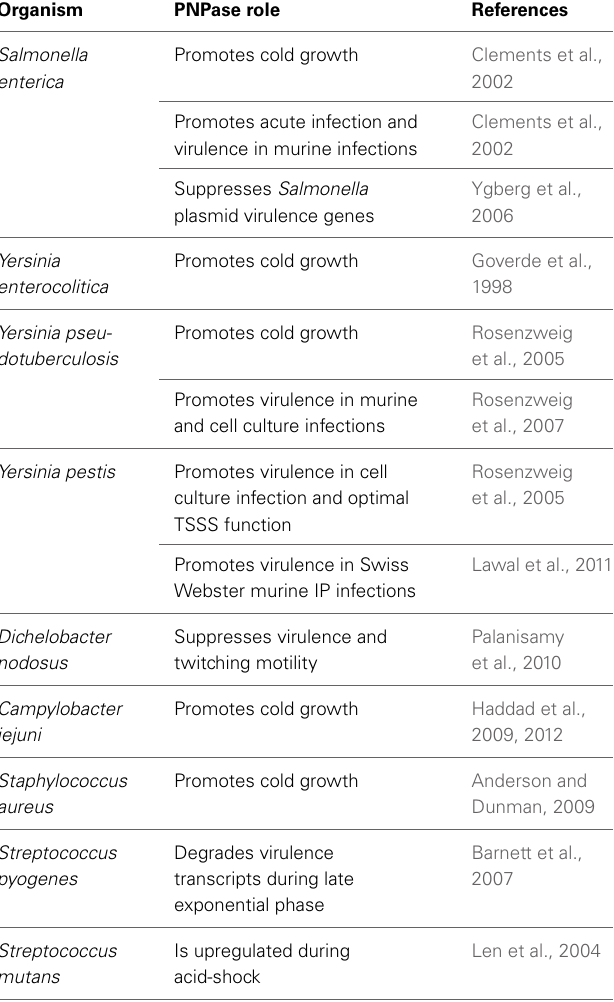
Table 1 | List of PNPase influences on various bacterial